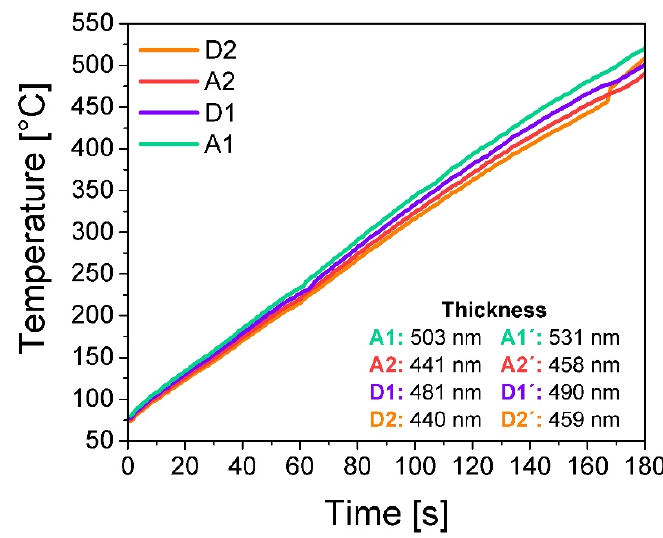
Figure 1. Substrate temperature during SiO x film deposition and thickness reached for each film.